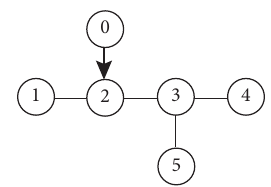
Figure 1: Communication topology.